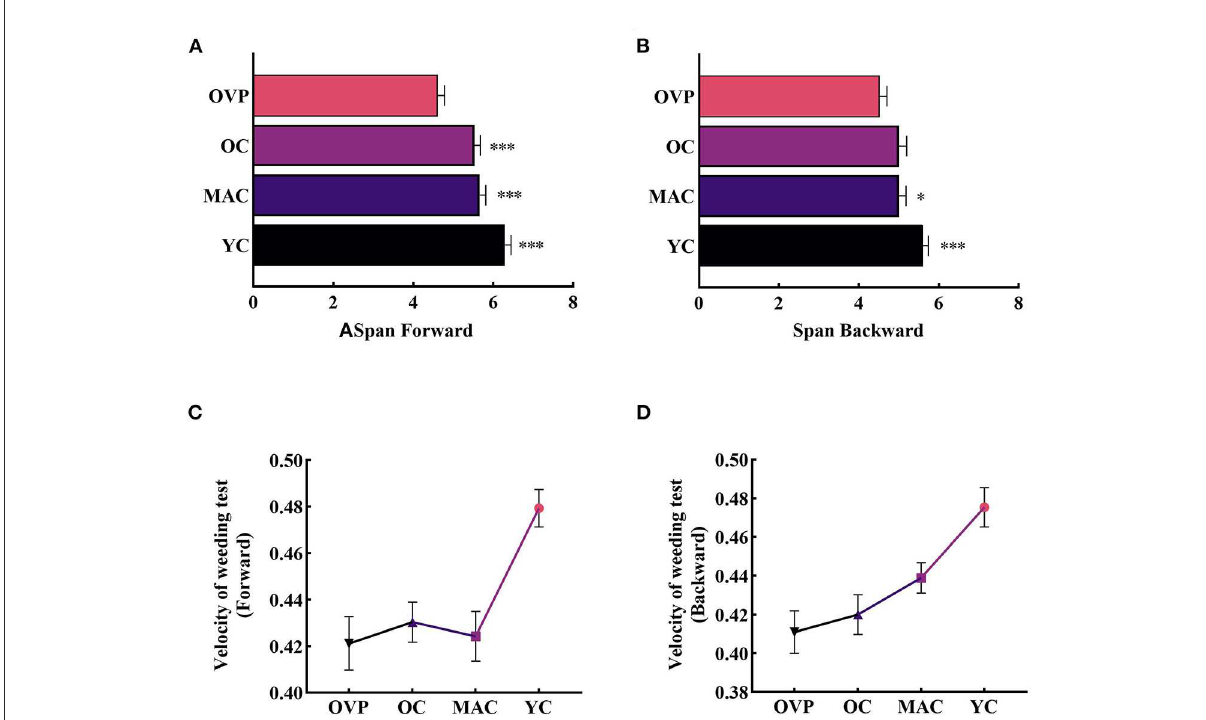
FIGURE2 Span and Velocity of Weeding test between groups. (A) Span in the forward condition. (B) Span in the backward condition. (C) Velocity in the forward condition. OVP group only performed worse than YC group ( p < 0.001). (D) Velocity in the backward condition. Older vertigo patients (OVP) performed worse than middle-aged controls (MAC) ( p < 0.05) and young controls (YC) ( p < 0.001). Post-hoc multiple comparisons between groups using OVP group as reference, significantly differences were indicated by the asterisk. OVP, Older vertigo patients; OC, Older controls; MAC, Middle-aged controls; YC, Young controls. * p < 0.05; *** p < 0.001. Error bars indicate the SEM.